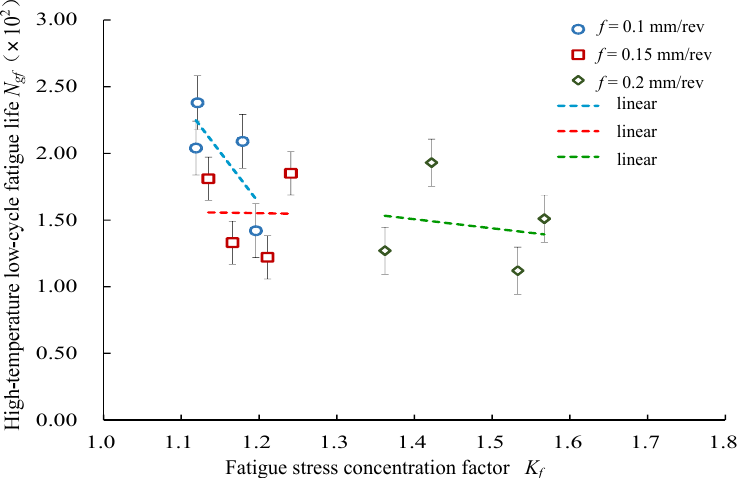
Figure 13. Effects of fatigue stress concentration factor K f on high-temperature low-cycle fatigue life.